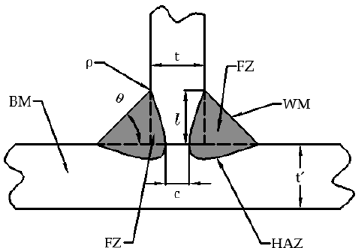
Figure 1. Schematic diagram of the fillet joint. Figure 2. Schematic diagram of the butt joint.